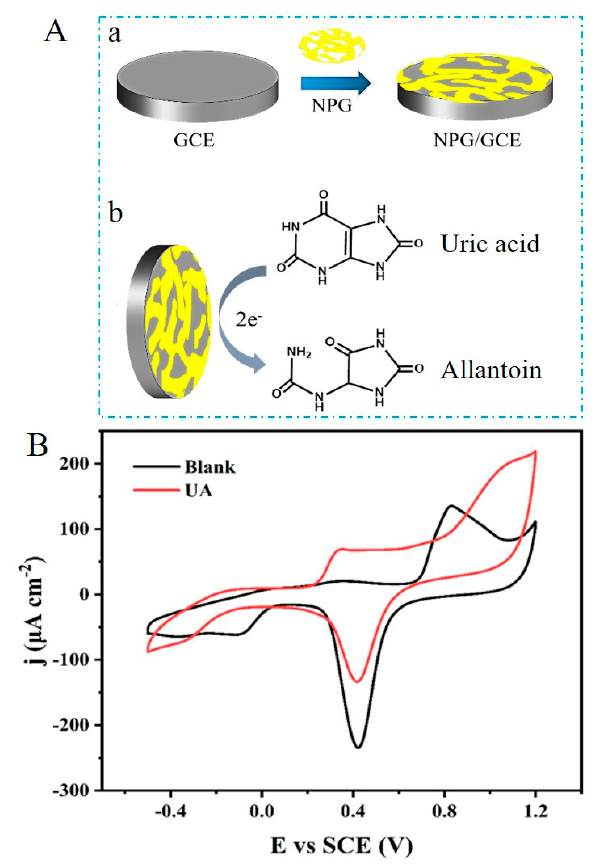
Figure 2. ( A ) Schematic diagram for the construction of NPG/GCE (a) and catalytic oxidation of uric acid by the NPG/GCE (b). ( B ) The CV curves of NPG/GCE in PBS (50 mM, pH 7.0) with and without 1.0 mM uric acid a scan rate of 50 mV s − 1 .